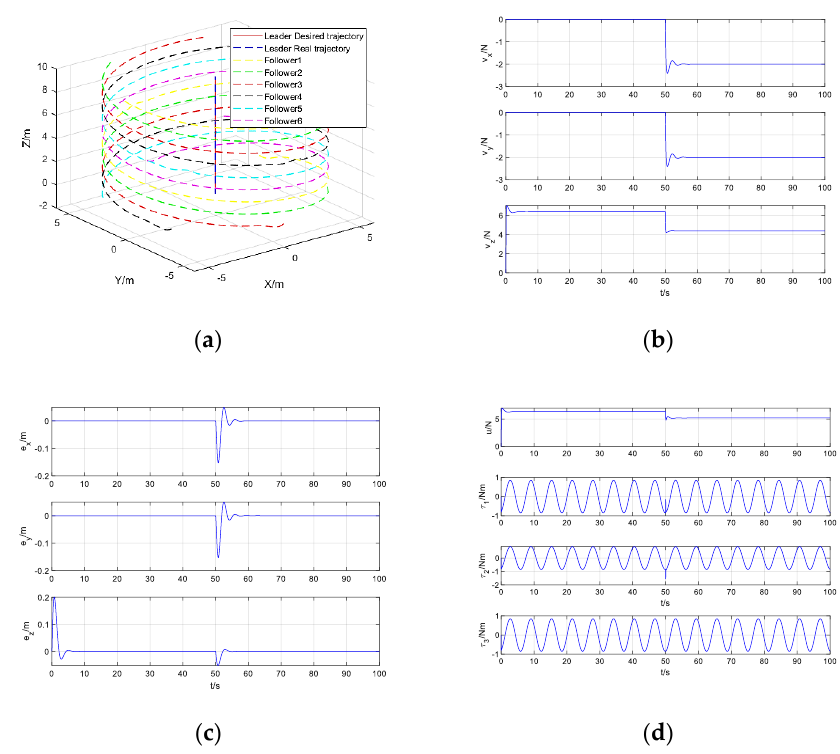
Figure 5. Simulation results of quadrotor formation cooperative trajectory tracking: ( a ) Formation cooperative trajectory tracking; ( b ) Virtual control input; ( c ) Trajectory tracking error; ( d ) Control